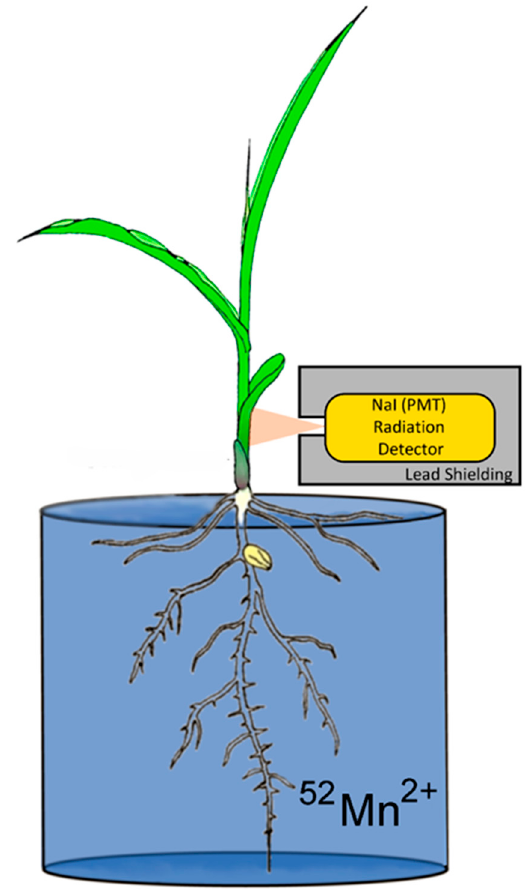
Figure 1. Experimental setup for monitoring plant uptake of radioactive 52 Mn 2+ .